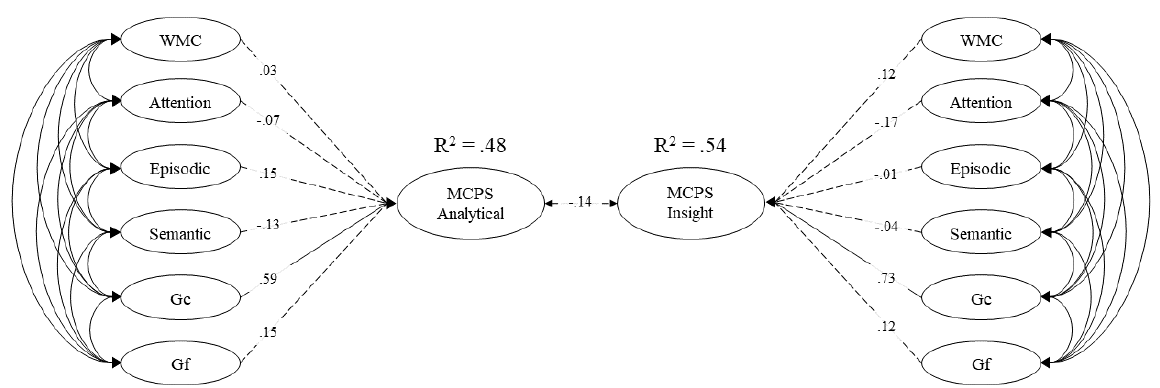
Figure 5. The full structural model of working memory capacity (WMC), attention control (attention), episodic memory (episodic), semantic memory (semantic), crystallized intelligence (Gc), and fluid intelligence (Gf) loading on both multiply-constrained problem solving strategies (analytical and insight). Dashed lines represent nonsignificant paths. Values on paths represent standardized regression coefficients.